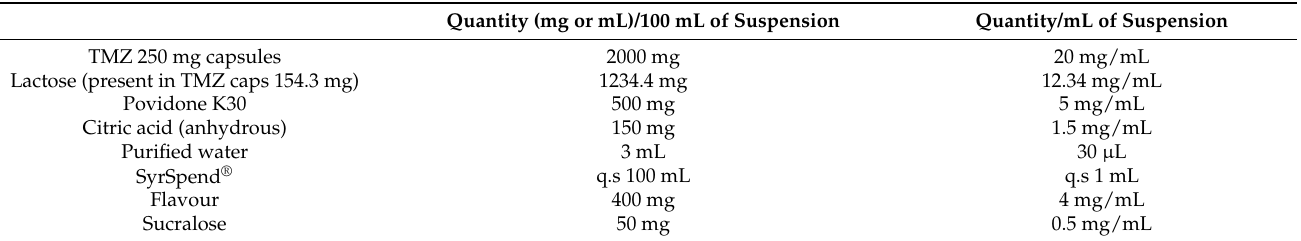
Table 1. TMZ suspension composition. Quantity of TMZ and excipients per 100 mL (1 bottle) or per mL of suspension.